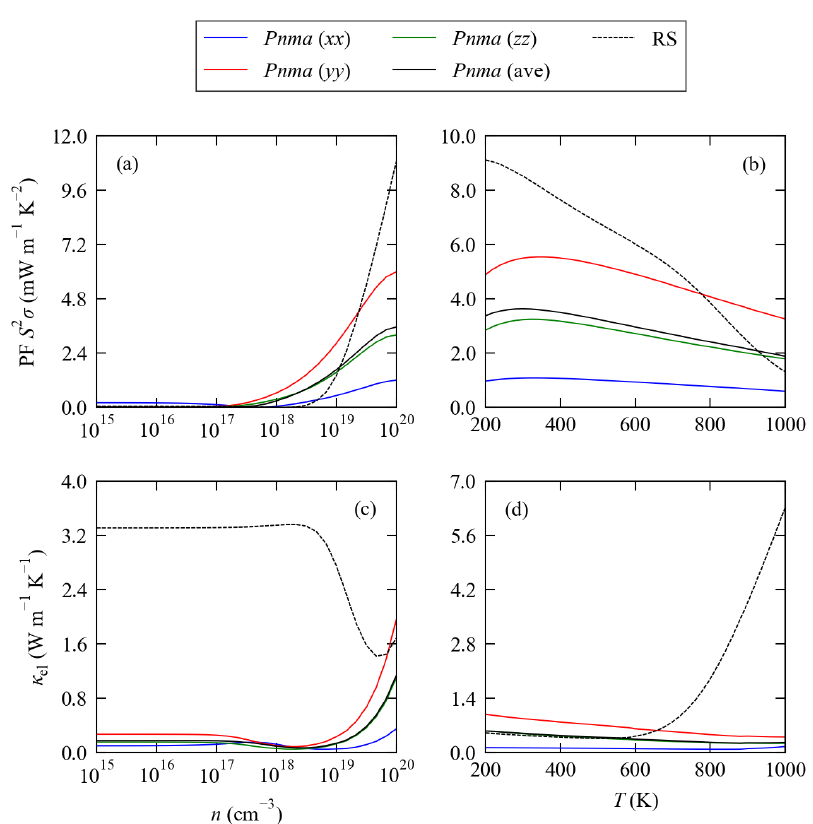
Figure 4. Anisotropy in the electronic transport of SnSe. The plots show the diagonal xx , yy , and zz components of the power factor S 2 σ (PF) ( a , b ) and electronic thermal conductivity κ el ( c , d ) of the orthorhombic Pnma phase of SnSe together with the isotropic averages calculated using Equations (9)–(11). The isotropic averages of the rocksalt phase, for which the three diagonal com- ponents are equal, are also shown for comparison. As in Figure 3, both properties are shown as a function of carrier concentration n for a fixed T = 800 K ( a , c ) and as a function of temperature for a fixed n = 2.15 × 10 19 cm − 3 ( b , d ).